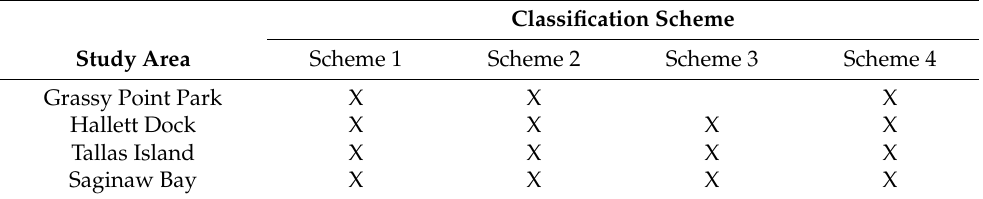
Table 3. Classification schemes used at each study area. This includes: Scheme (1) strictly the RGB UAS imagery using rule set 1; Scheme (2) RGB UAS imagery and a UAS-derived CHM using rule set 2; Scheme (3) RGB UAS imagery and a stereo satellite-derived CHM using rule set 2; Scheme (4) RGB UAS imagery, UAS-derived CHM, and the RADARSAT-2 HH polarization using rule set 3. Scheme (3) was not used for Grassy Point Park due to data